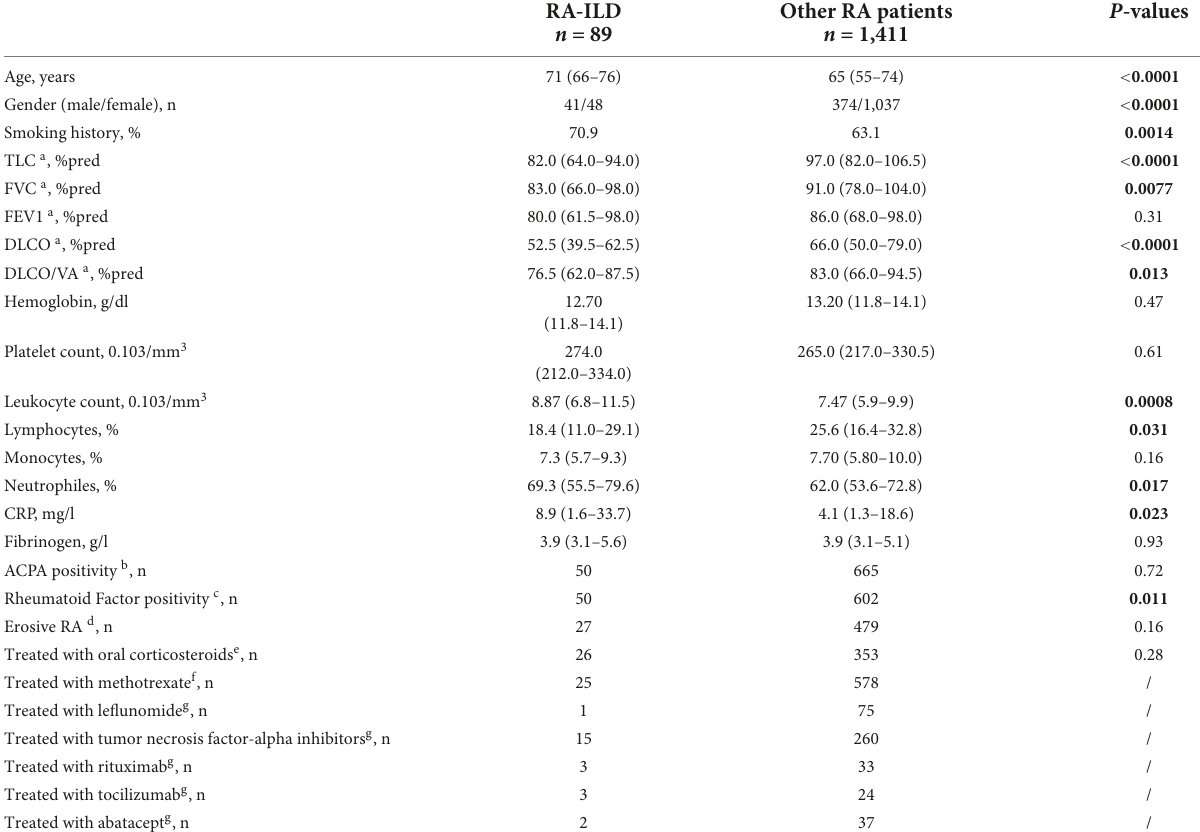
TABLE 1 Comparison of patients’ characteristics between RA-ILD ( n = 89) and other RA patients ( n = 1,411).